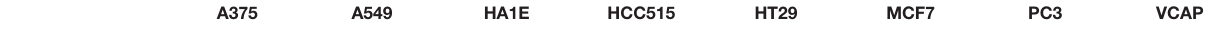
TABLE 2 | Molecular targets used in this work, with number of active and inactive compounds in total, and in each cell line GES